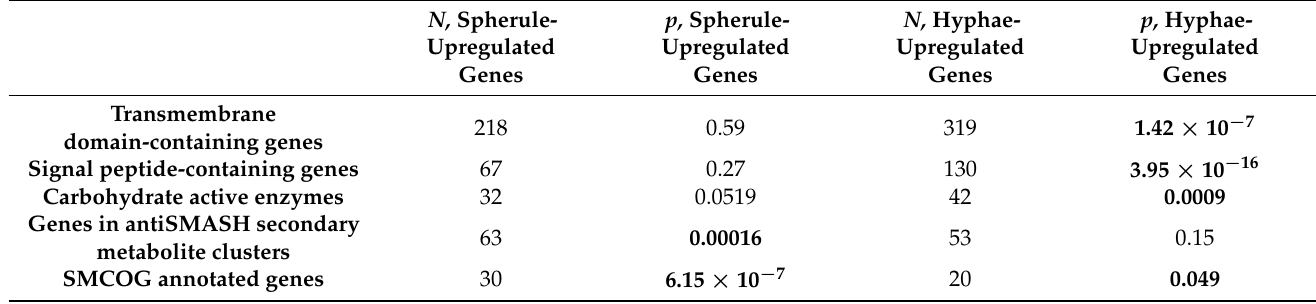
Table 1. Functional annotation of genes with life cycle-specific expression. Each row reports the results of tests for enrichment of C. posadasii genes of the indicated annotation class among those induced in spherules (first two columns) or hyphae (last two columns). N: number of genes in category; p : resampling-based enrichment p-value; antiSMASH: antibiotics and Secondary Metabolite Analysis Shell; SMCOG: antiSMASH Secondary Metabolite Clusters of Orthologous Groups. Bold values signify p <